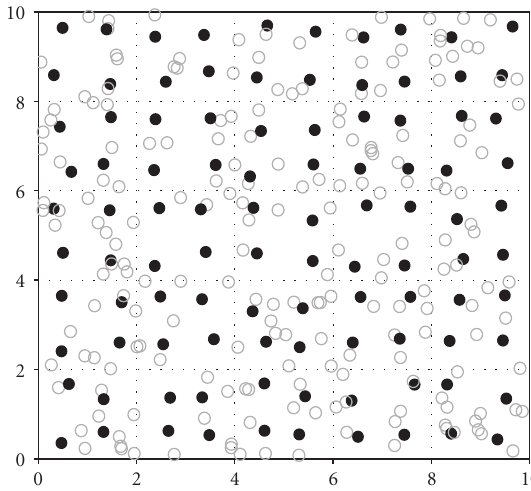
Figure 3: Regular point set, Point map. Grey circles are from a Poisson process. Black disks are located close to a 1 × 1 square grid.